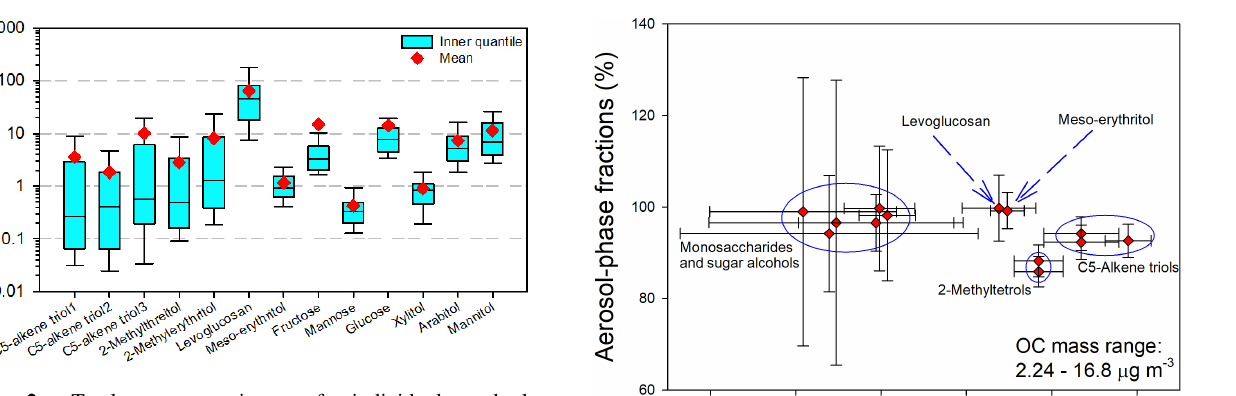
Figure 2. Total concentrations of individual polyols ( Q f + Q b + PUF) in the ambient atmosphere of northern Nanjing. The boxes depict the median (dark line), inner quantile range (box), 10th and 90th percentiles (whiskers), and mean (red diamond).